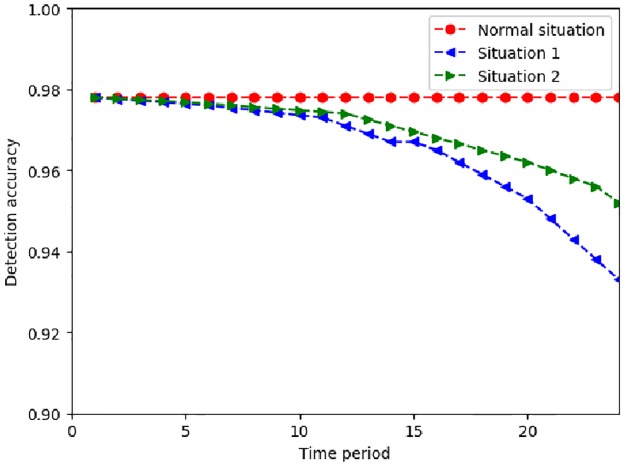
Detection accuracy rate changes with untrusted nodes.